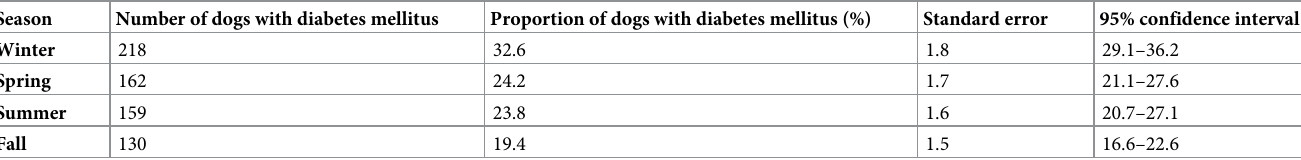
Table 4. Seasonality of diabetes mellitus diagnosis in 669 dogs with diabetes mellitus. Season Number of dogs with diabetes mellitus